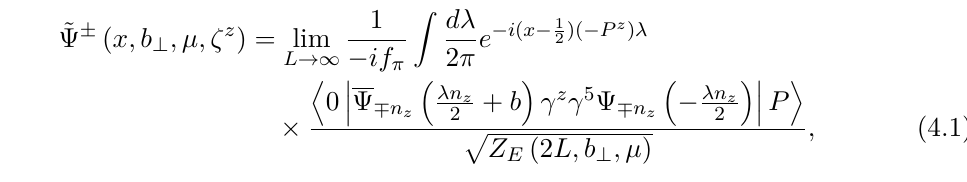
JHEP09(2022)046